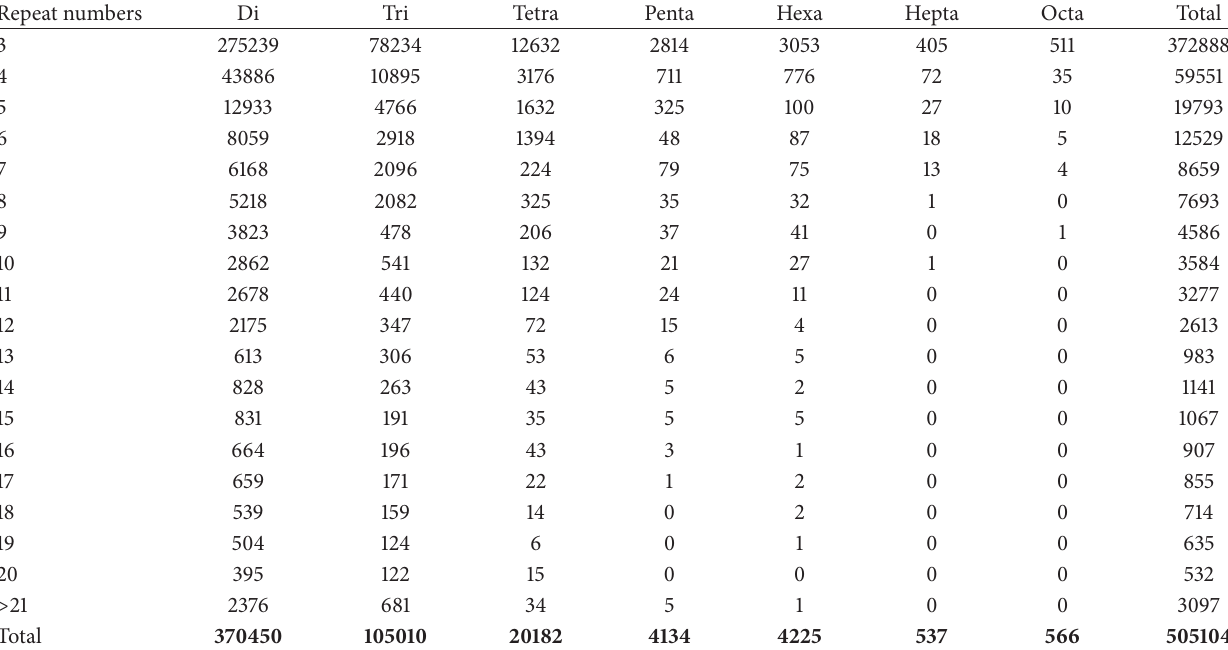
Table 5: Distribution of simple sequence repeat (SSR) among the unigenes of Vespa mandarinia based on the number of repeat